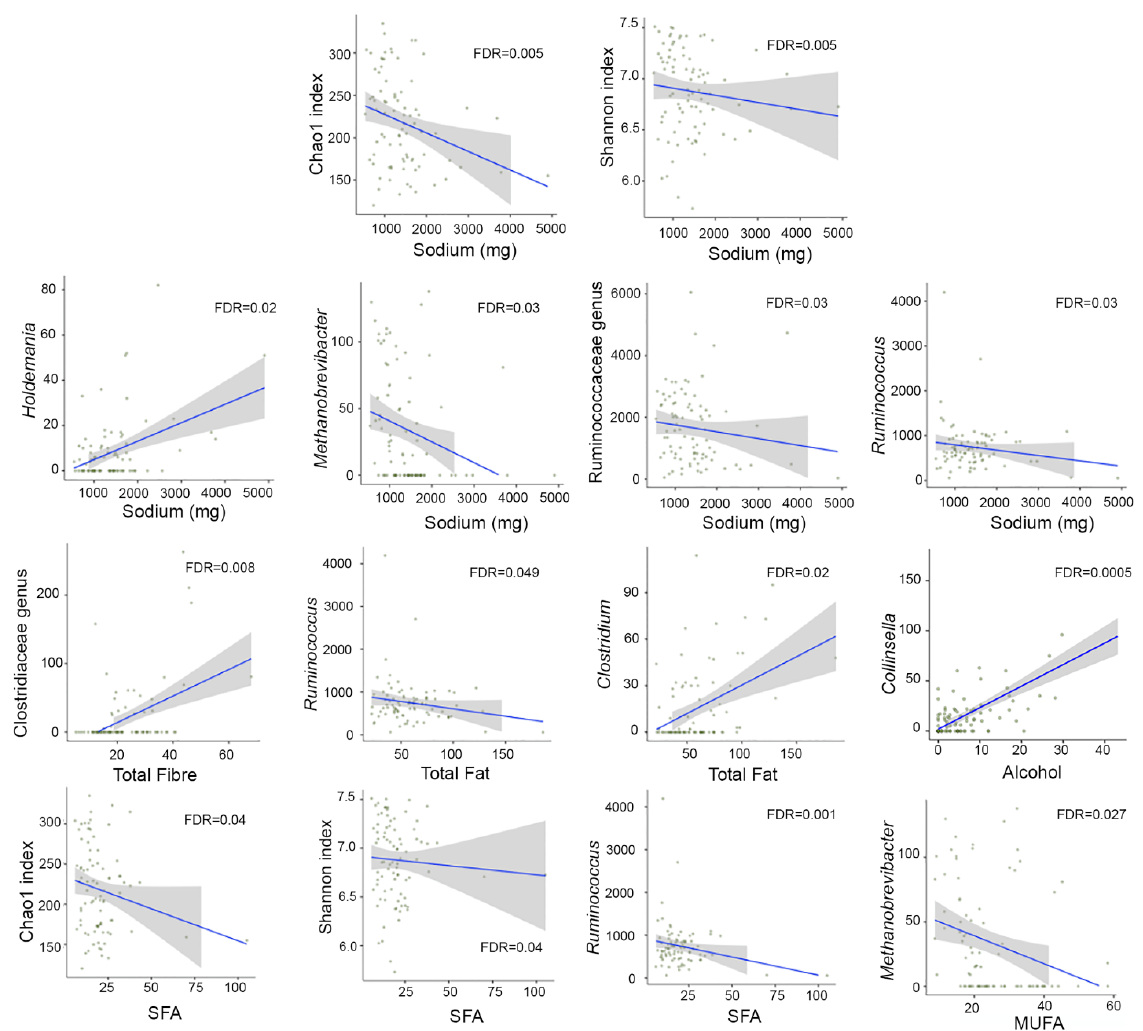
Figure 5. Correlation between nutrients and microbial diversity and taxa. Linear mixed models implemented in MaAsLin2 were used to analyse the microbiome diversity and taxonomic profile and nutrients data extracted from the validation study ( n = 44, 85 faecal samples). SFA, saturated fatty acids; MUFA, monounsaturated fatty acids. All nutrients except for sodium (in mg) are displayed in grams.